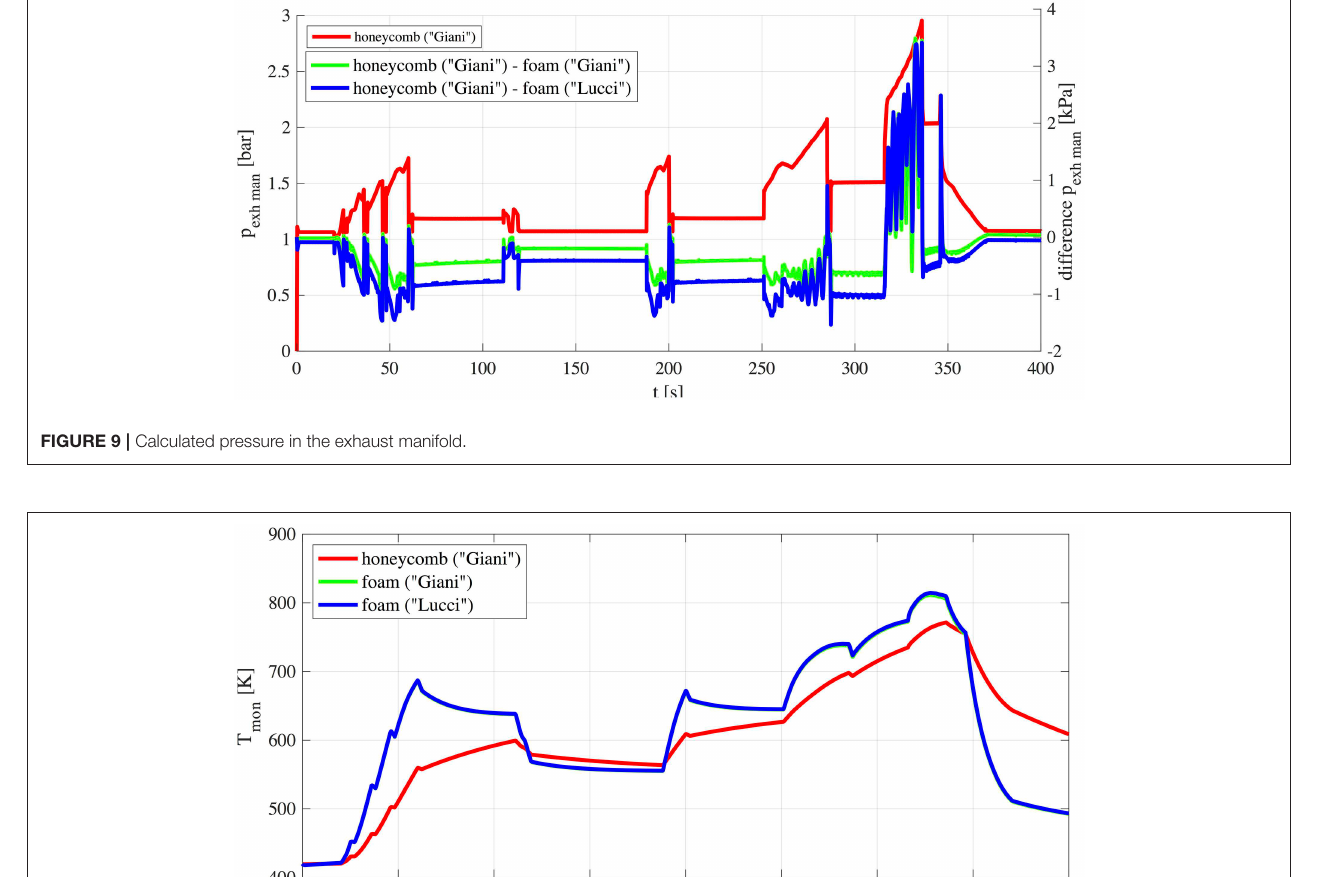
and green lines show the percentage deviation when the foam (green solid line, “f_Giani”) and Kelvin Cells substrates (blue solid line, “f_Lucci”) are used with reference to the honeycomb one